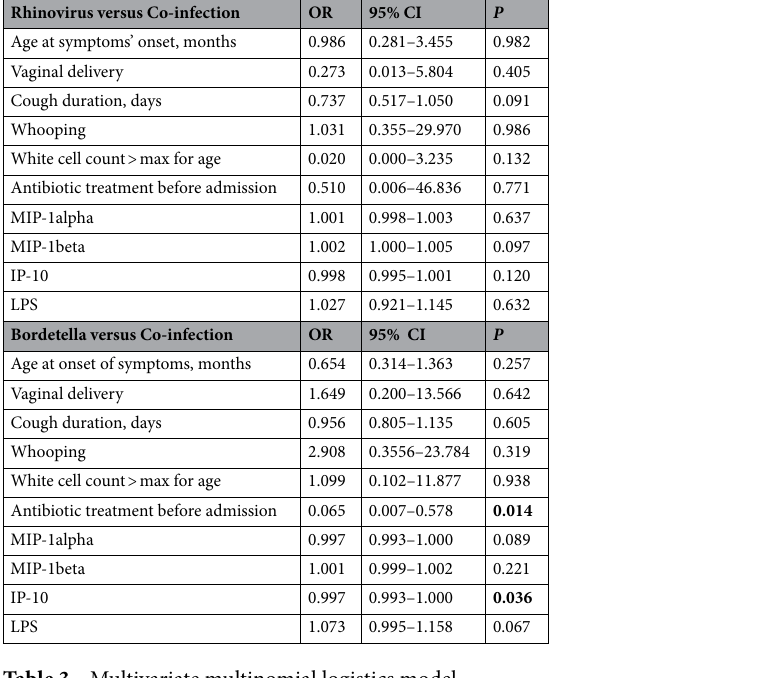
Table 3. Multivariate multinomial logistics